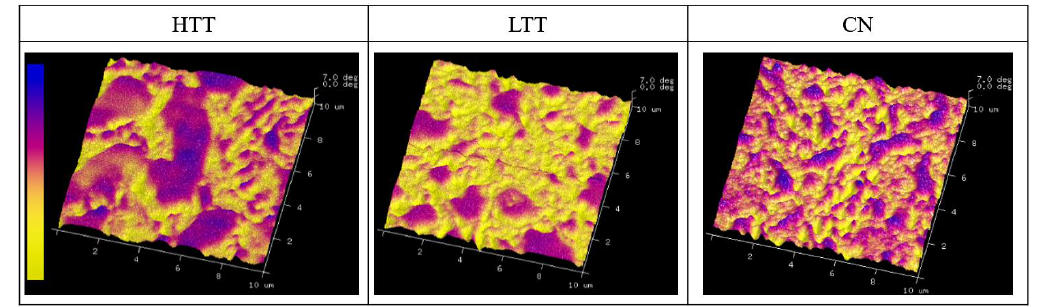
Figure 3. 3D magnetic response maps with changes in height representative of differences in magnetism. Color scale ranges are 7 degrees (0° = yellow, +7° = blue) for magnetic response.